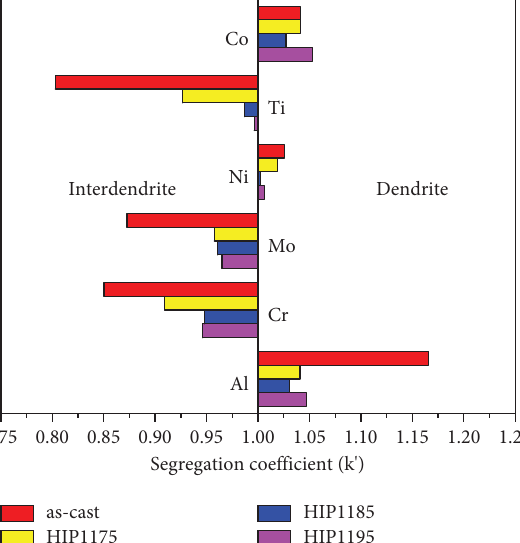
Figure 14: Microsegregation coefcient in the dendrite core and interdendritic region of as-cast and diferent HIP treatments of K417G alloys, k ′ .